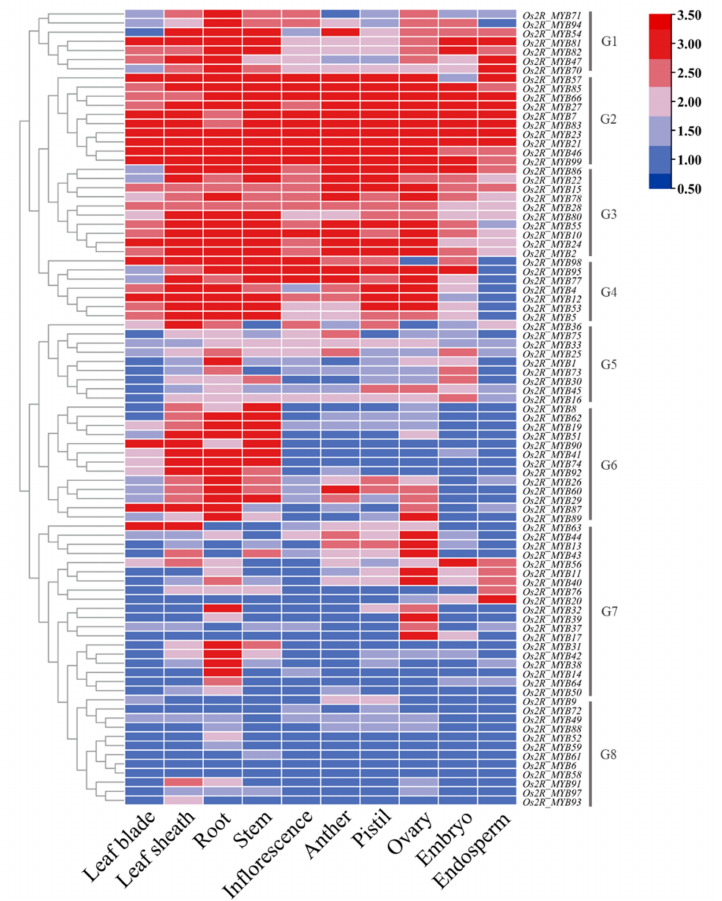
Figure 7. The relative expression level of Os2R_MYB genes in various tissues and growth stages. Lower expression is represented with dark blue; higher expression is represented with red. Leaf-blade, vegetative leaf-blade; Leaf-sheath, vegetative leaf-sheath; Root, vegetative root; Stem, reproductive stem; Inflorescence, 0.6–1 mm; Anther, 0.7–1 mm; Pistil, 5–10 cm; Ovary, 3 DAF; Embryo, 10 DAF; Endosperm, 42